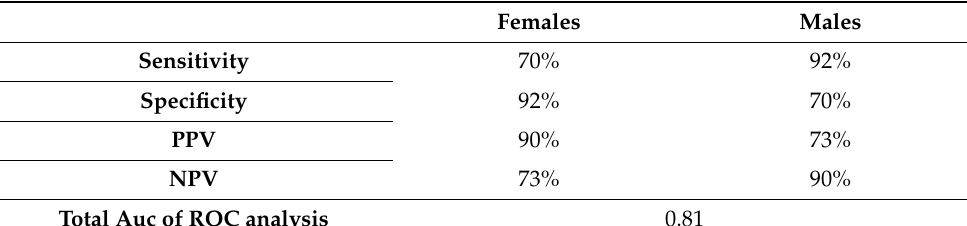
Table 1. Sensitivity, specificity, positive predictive value, and negative predictive value stratified by sex. The accuracy values were 80% and the ROC analysis yielded an overall value of